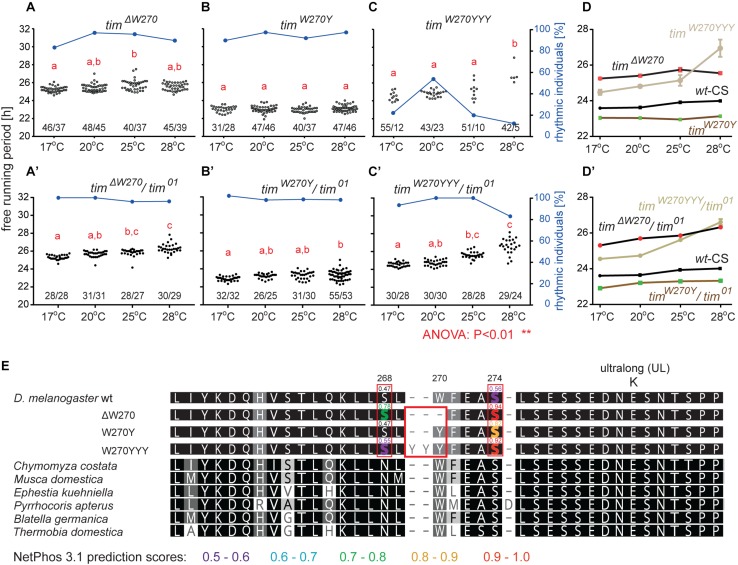
Mutants isolated upstream of timUL. (A–C) Each dot represents τ of individual fly as was recorded during 10 days in DD and specified temperature. Lowercase red letters above dots indicate a significant difference between “a” and “b” and “c” and “d” (one-way ANOVA with Tukey–Kramer’s post hoc test, P < 0.01). Numbers below dots correspond to number of measured/rhythmic flies at particular temperature. Blue dots connected with line correspond to percentage of rhythmic individuals (scale on right y-axis) at particular temperature. Panels A–C contain phenotypes of homozygous flies, whereas A’–C’ are dedicated to heteroallelic combinations with tim01. Comparison of τ (shown as mean ± SEM) for all three mutants and wild-type (Canton strain) flies (wt-CS) for (D) homozygotes and (D’) heteroallelic combinations with tim01. (E) Alignment of mutant protein sequences with TIM from representative insects (see the text and legend of Figure 1 for more details on insect taxons). Mutation in position 270 (red box) possibly affects phosphorylation of serine residues in positions 268 and 274 (highlighted by red boxes). Only residues which phosphorylation is possibly affected by mutation are highlighted in the alignment of mutants and wt TIM proteins and prediction scores are indicated above the amino acid. The colors correspond to score prediction from NetPhos 3.1 (color coding is shown below the alignment).